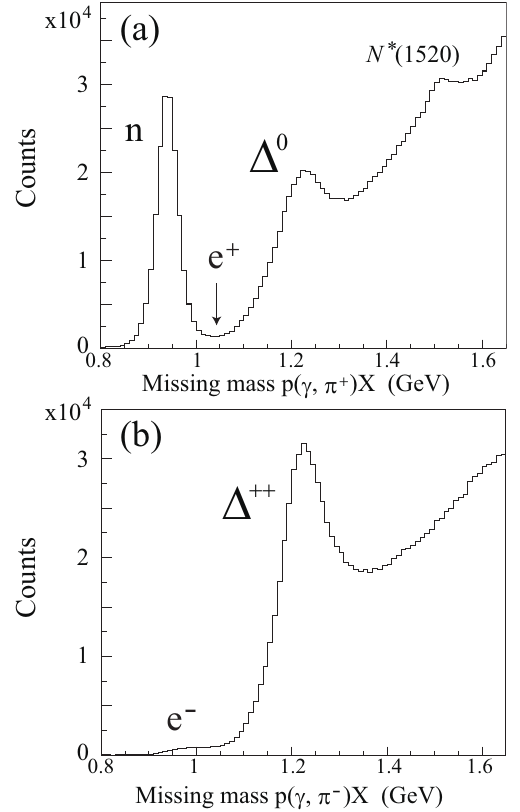
Figure 4. Missing mass of the (a) γ p → π + X and (b) γ p → π − X reactions for 0.7 < cos θ cm < 1 and E γ = 1.5-2.95